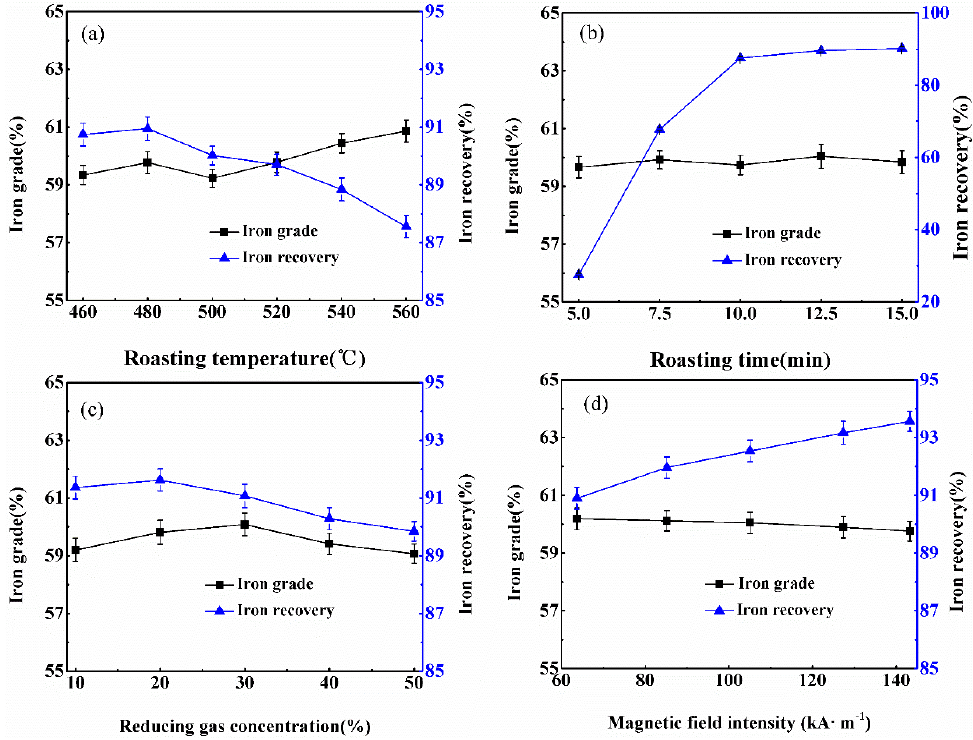
Figure 4. Effect of roasting conditions on the recovery and Fe grade of the magnetic concentrate: ( a ) roasting temperature, ( b ) roasting time, ( c ) reducing gas concentration, ( d ) magnetic field intensity.